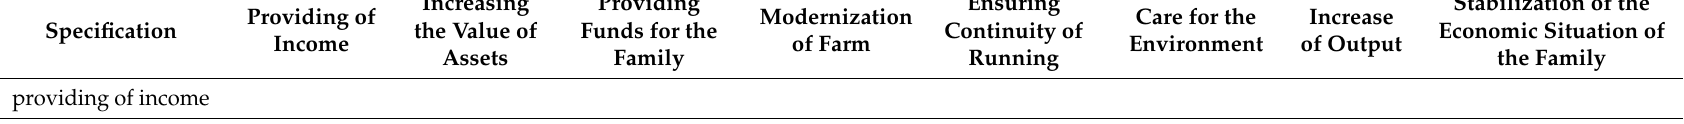
Table 5. Correlation of Spearman’s rank between the objectives of the examined agricultural holdings in the Wielkopolska region.